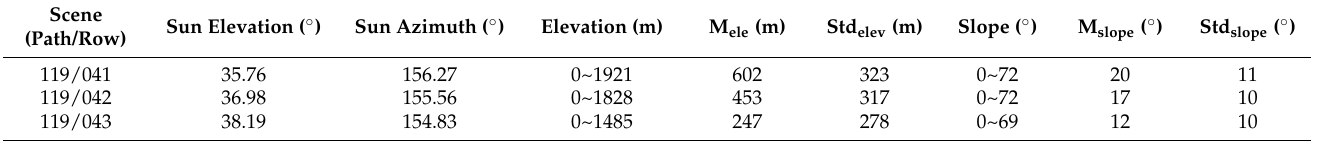
Figure 1. Study area location and images: Landsat 8 Operational Land Imager (OLI) acquired on 11 December 2019 (near infrared – red – green (NRG) composite), subareas (white rectangles, S1 – S3 are rugged areas located in the scenes of 119/041, 119/042, and 119/043, respectively), sample areas (green points), and samples (yellow points). Table 1. Path/row, sun elevation, and azimuth of the Landsat 8 OLI and corresponding elevation and slope of study area. M ele is mean of elevation, Std ele is standard deviation of elevation.